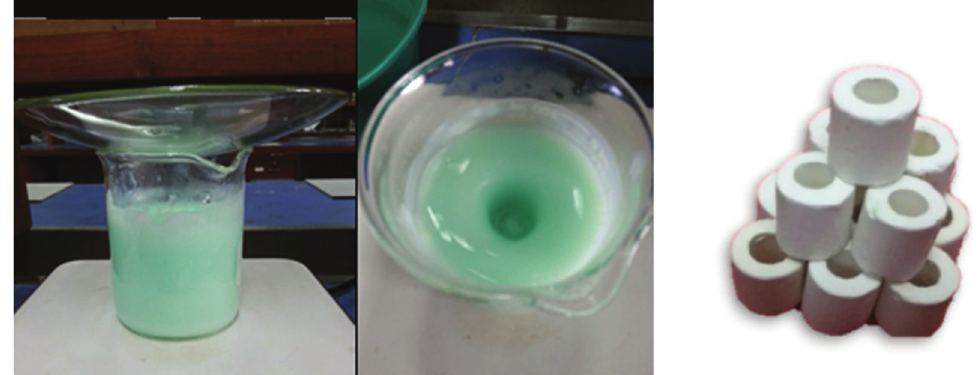
Fig. S1 – Schematic diagram of the catalyst coating on the wall surface of the Raschig ring